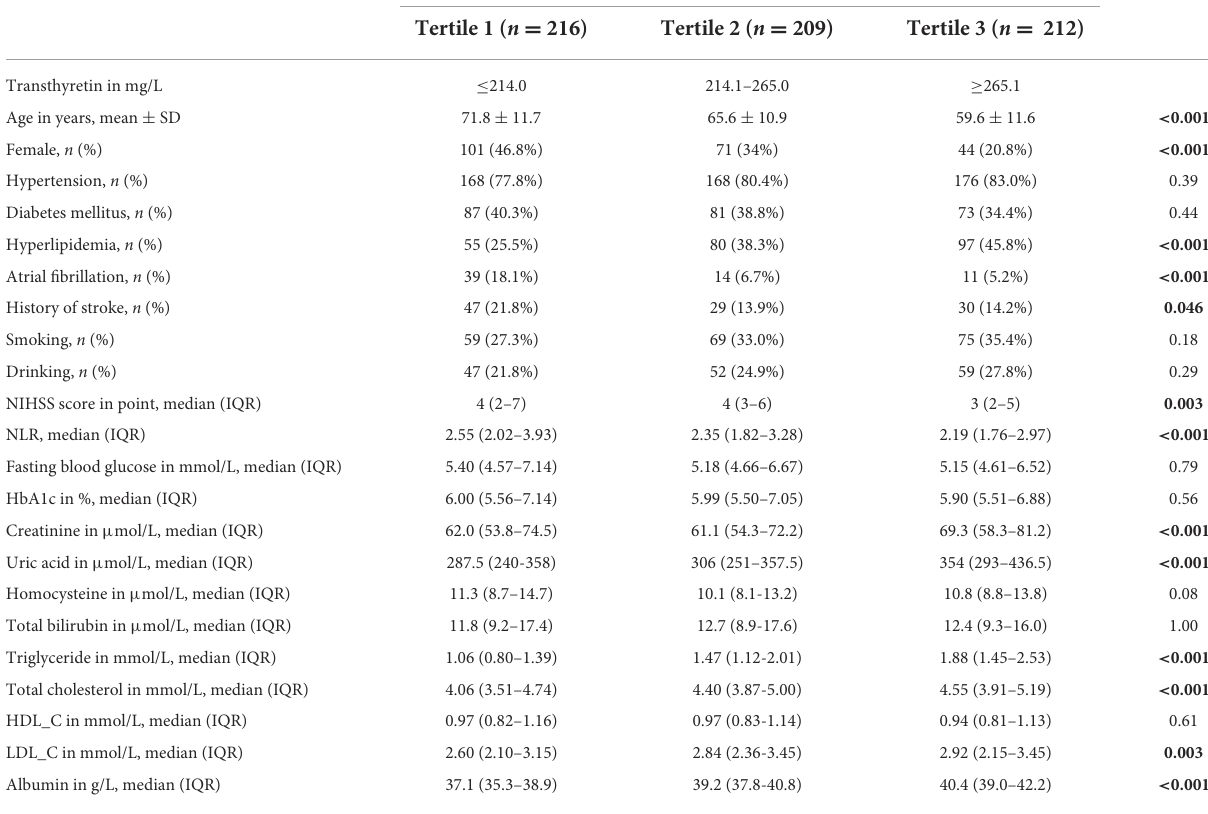
TABLE 1 Clinical characteristics of patients, stratified by the tertiles of